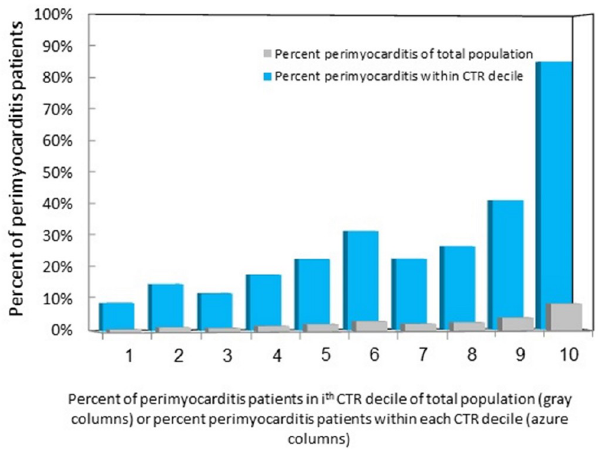
Fig 5. Bar graph of the prevalence of the diagnosis of perimyocarditis within the CTR deciles as percentage of total study population (gray) or as percentage of patients within each CTR decile (azure). It can be appreciated that as the CTR increases the percentage of perimyocarditis patients increases and so is its specificity. CTR- CRP/troponin ratio.